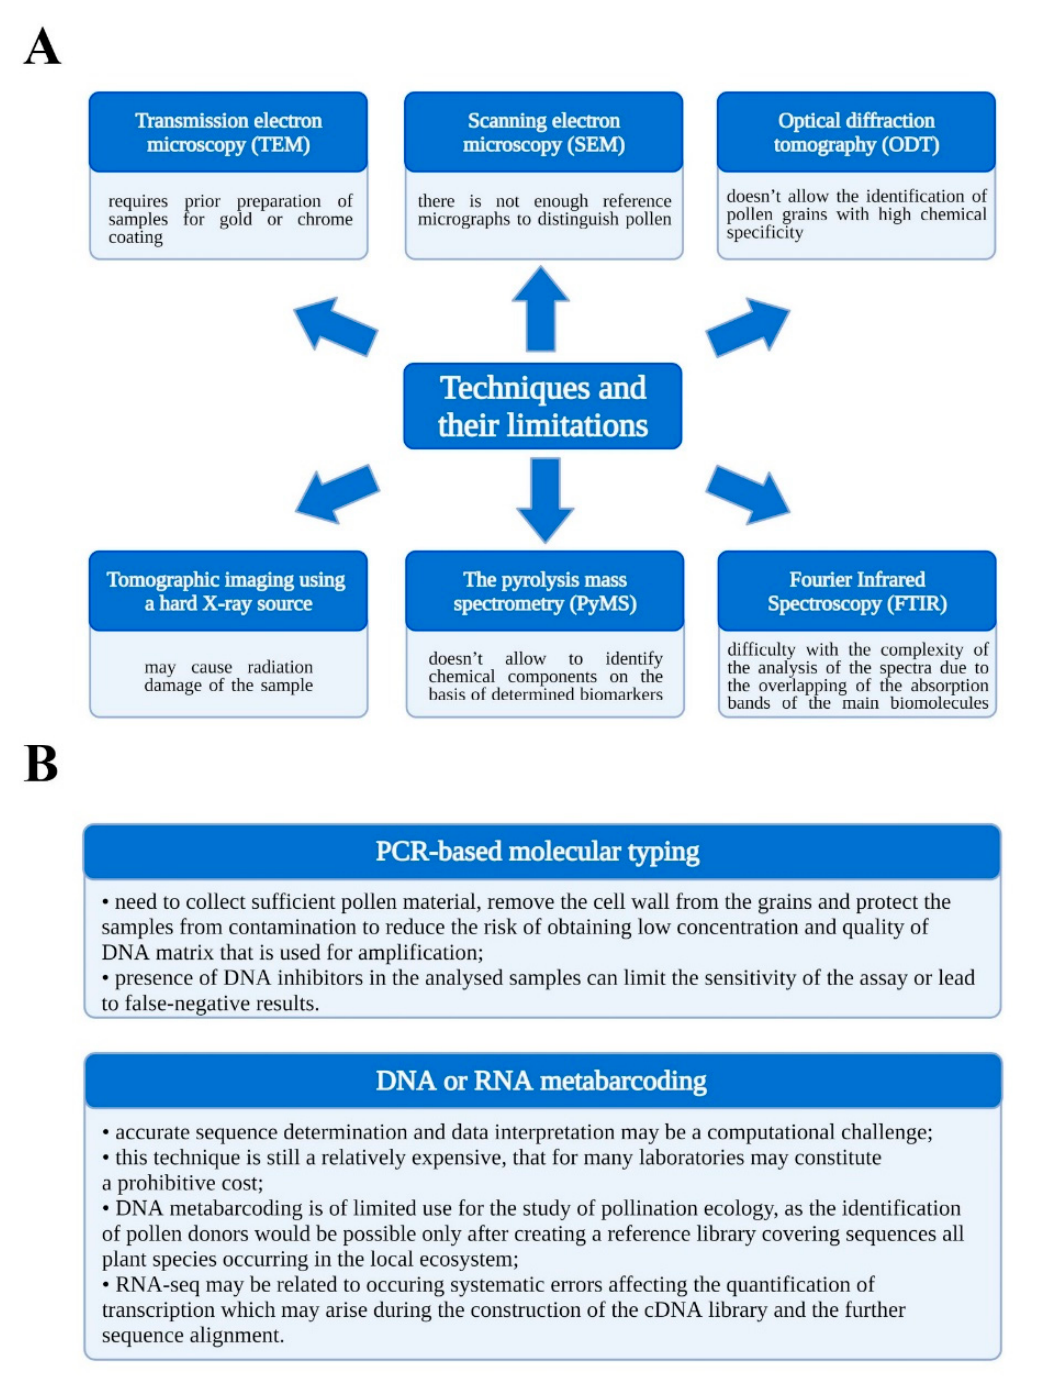
Figure 1. Techniques of pollen grains identification and their limitations ( A ), Limitations of molec- techniques for pollen grains identification ( B ular techniques for pollen grains identification ( B ).